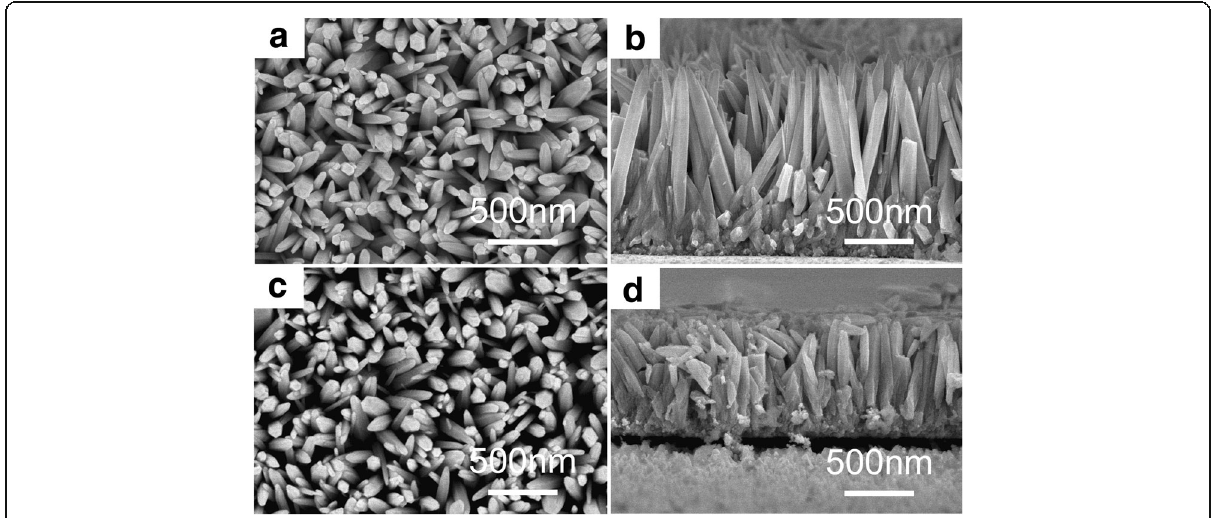
Fig. 3 The SEM images of 0 M ZnO and 0.08 M AZO nanospears, a top view and b side view of 0 M ZnO nanospears, c top view and d side view of 0.08 M AZO nanospears